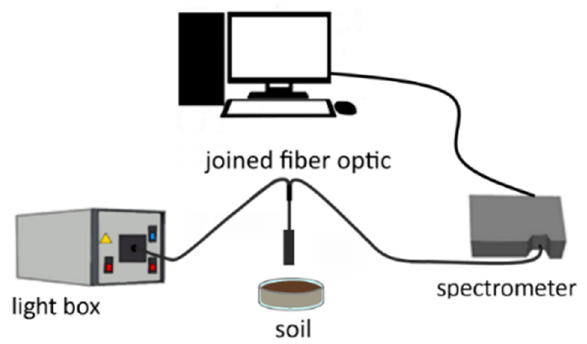
Figure 1. The experimental set-up for spectroscopic data acquisition.